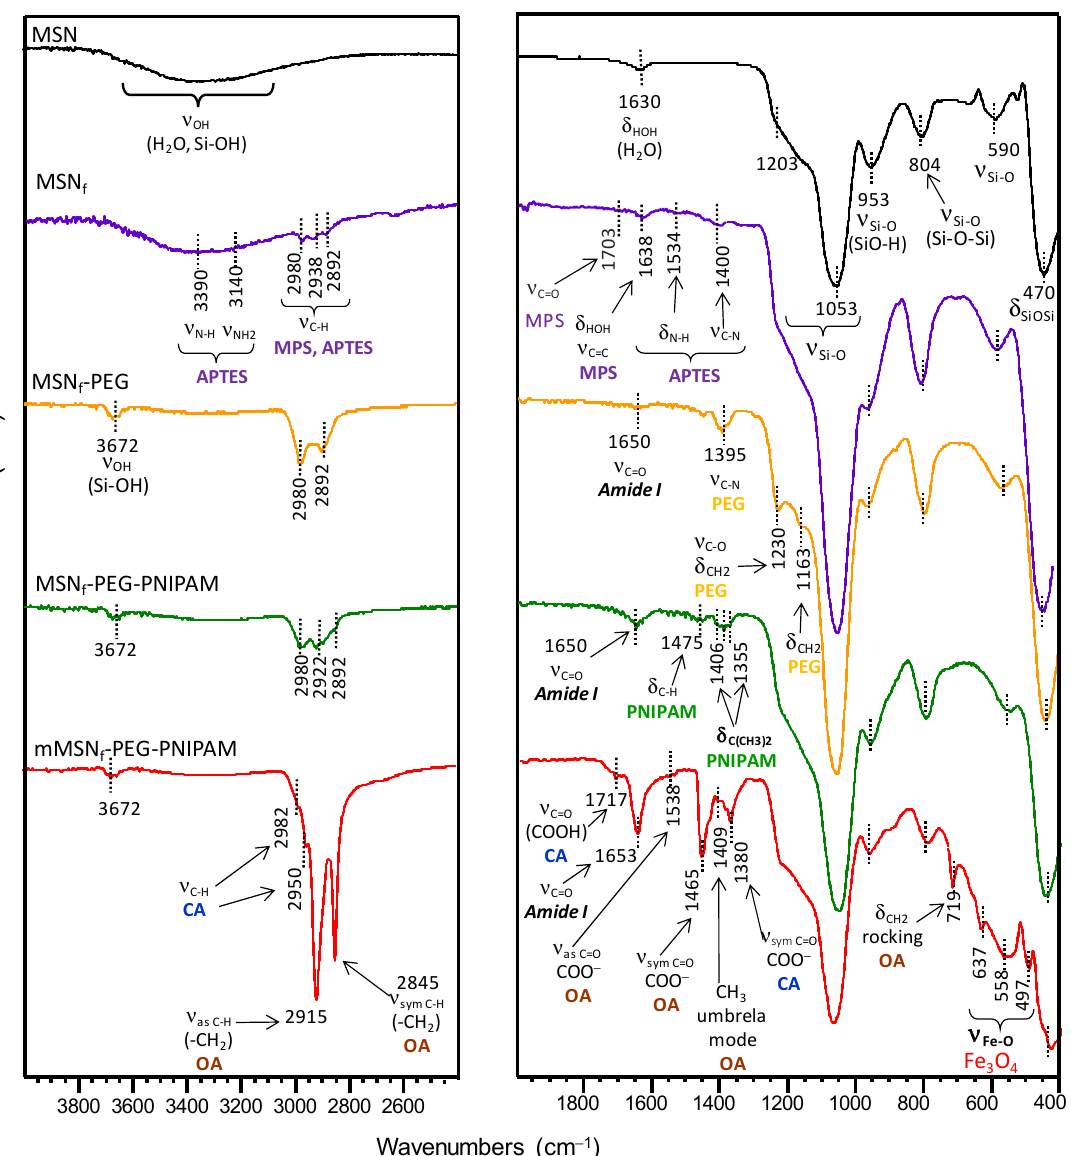
Figure 3. FTIR characterization of the different functionalization stages performed to obtain the final nanosystem mMSN f -PEG-PNIPAM.